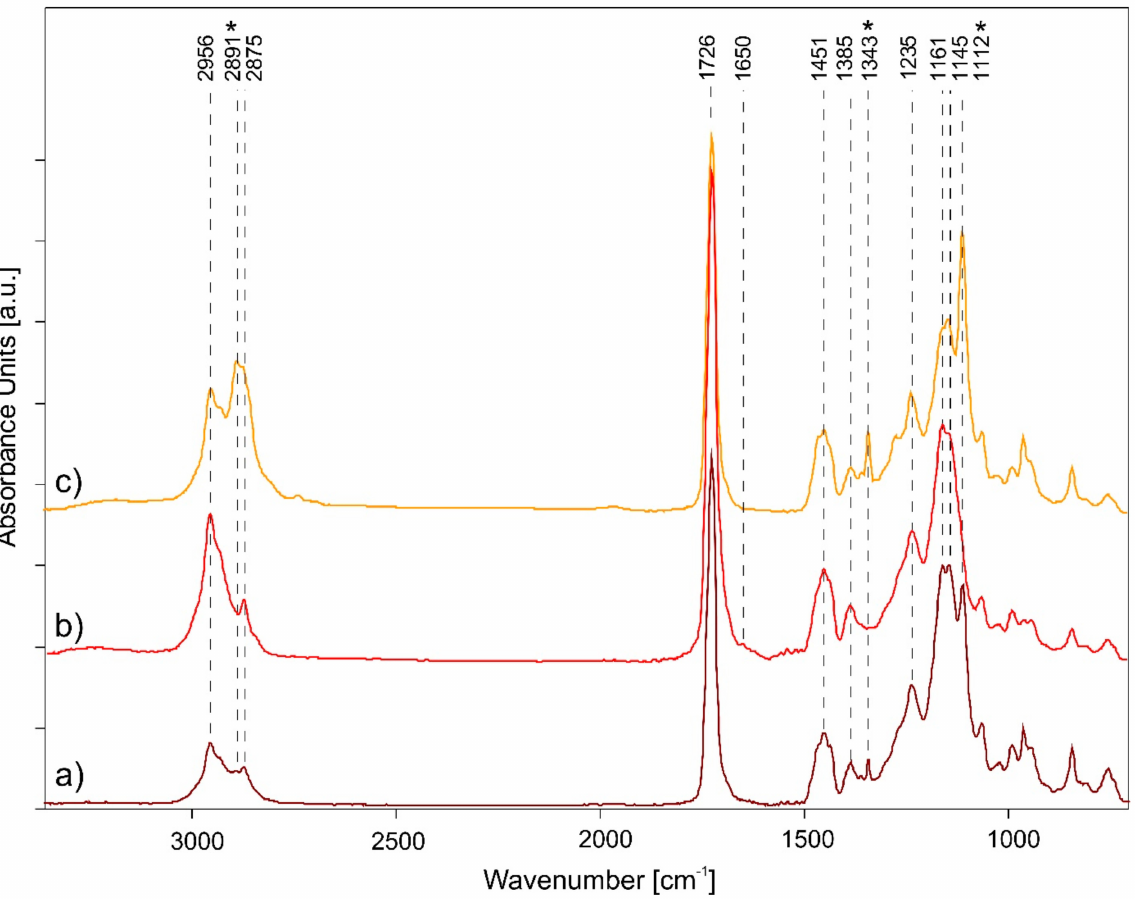
Figure 3. ATR-FTIR spectra comparison of pure acrylic films: ( a ) unaged (dark red), ( b ) 50% RH (red), and ( c ) 80% RH (yellow) aged samples are shown. The three main spectral signals of PEO surfactant are signed with